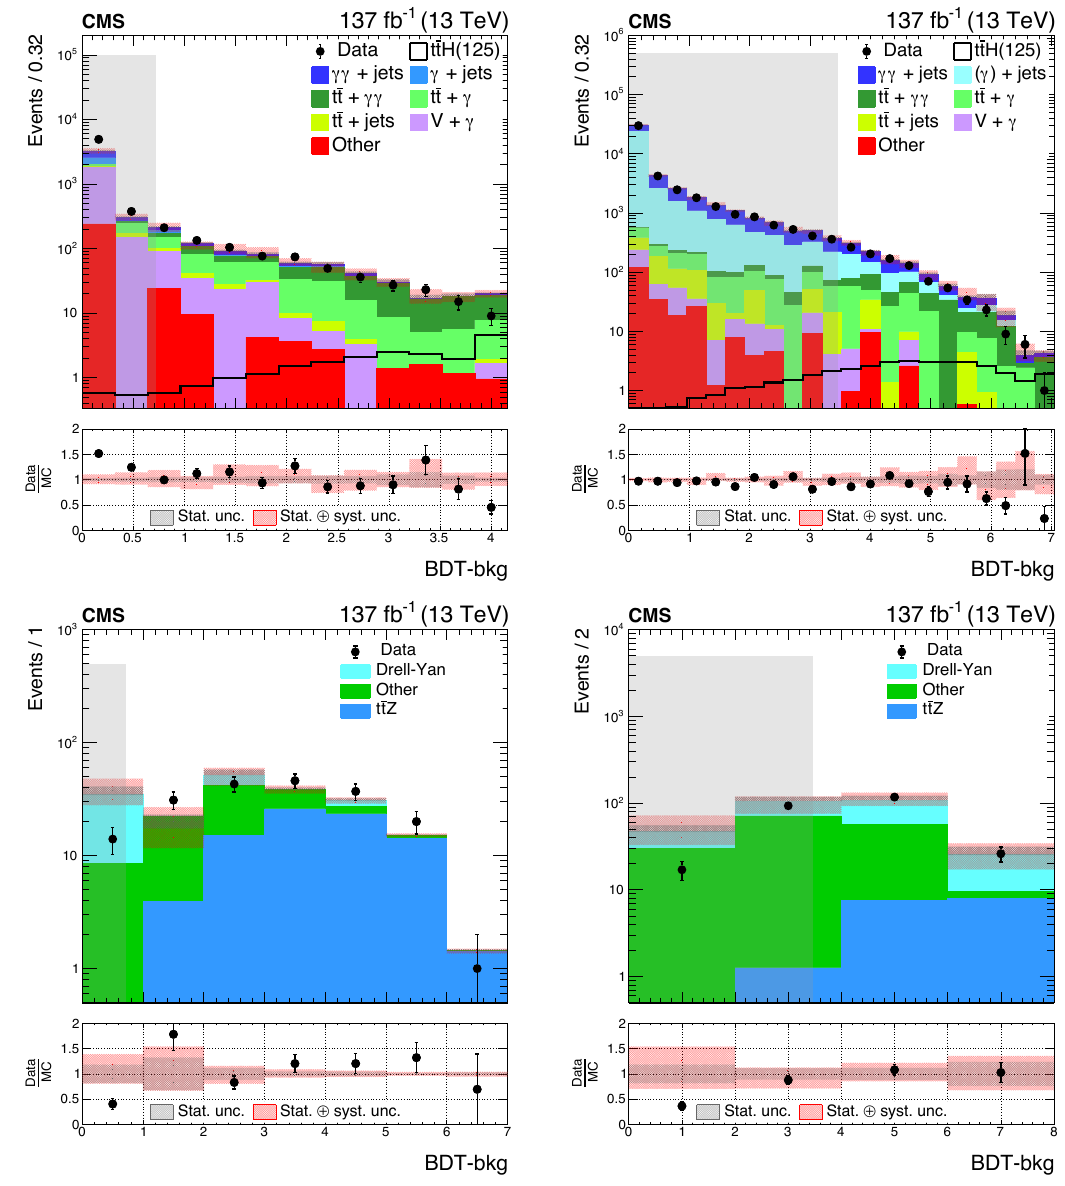
Figure 11 . Distributions of BDT-bkg output used in the analysis categories targeting ttH pro- duction, for the leptonic (left) and the hadronic (right) channels. The upper two plots show events taken from the m sidebands, satisfying either 100 < m < 120 GeV or 130 < m < 180 GeV. gg gg gg The lower two contain events from the ttZ control regions, described in the text. The grey region contains BDT-bkg scores below the lowest threshold for the ttH analysis categories. Total back- ground uncertainties (statistical ⊕ systematic) are represented by the black (pink) shaded